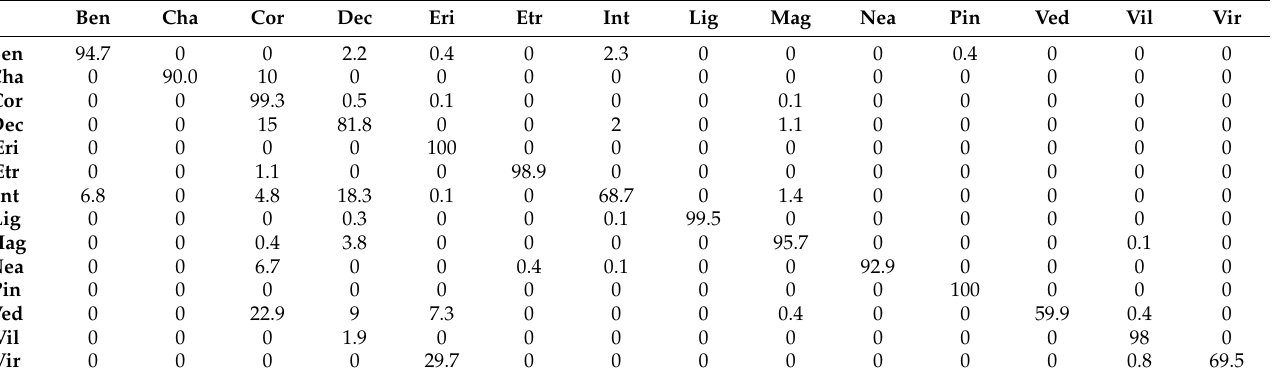
Table 2. The confusion matrix of the Random Forest method using species of the Santolina chamae- cyparissus complex as a priori groups. Values are percentages. Ben = S. benthamiana , Cha = S. chamaecyparissus , Cor = S. corsica , Dec = S. decumbens , Eri = S. ericoides , Etr = S. etrusca , Int = S. intricata